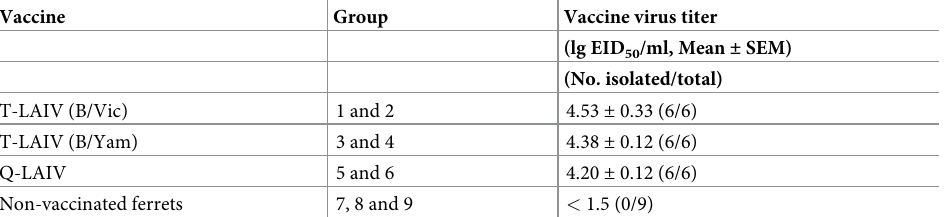
Table 2. Isolation of vaccine viruses from nasal washes of ferrets in embryonated chicken eggs on day 3 post